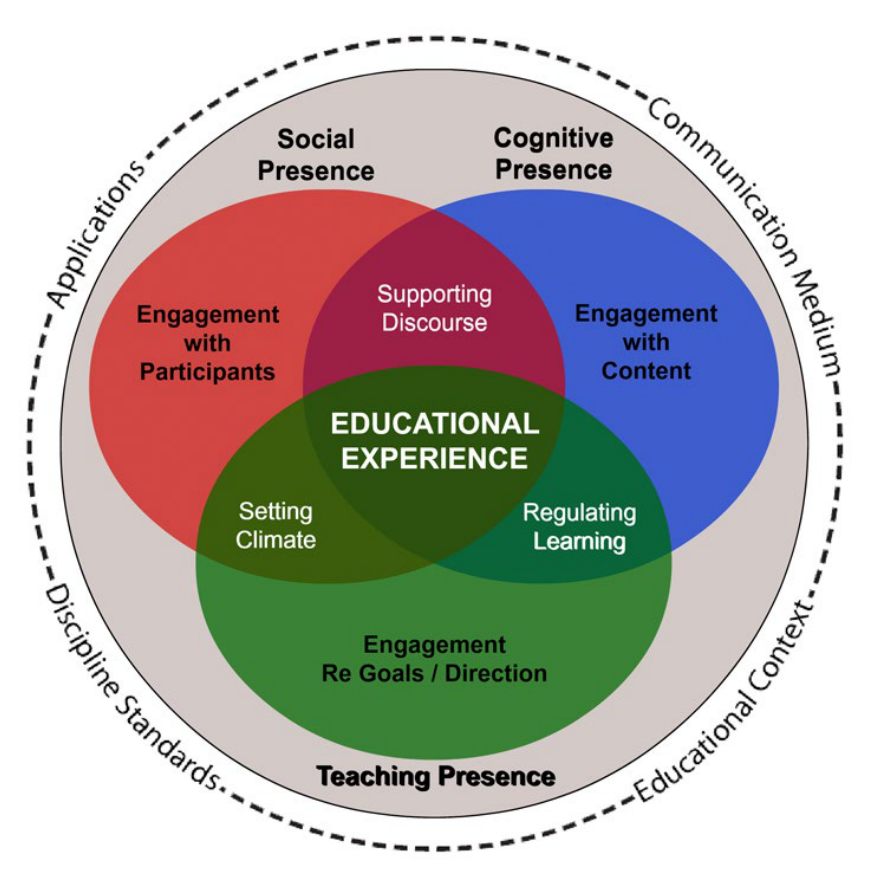
Community of Inquiry